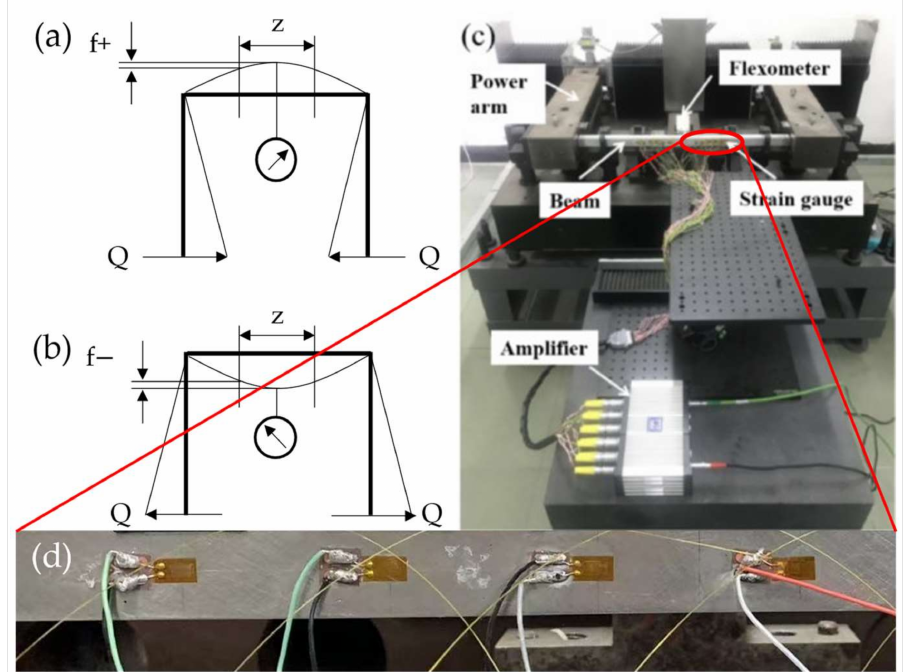
Figure 8. Testing apparatus for strain gauge parameters. A schematic diagram of the negative ( a ) and positive ( b ) strain produced in a standard elastic beam by a linear loading Q applied on the power arms. ( c ) The picture of the testing apparatus for strain gauge parameters. ( d ) Photo of a standard elastic beam with strain gauges